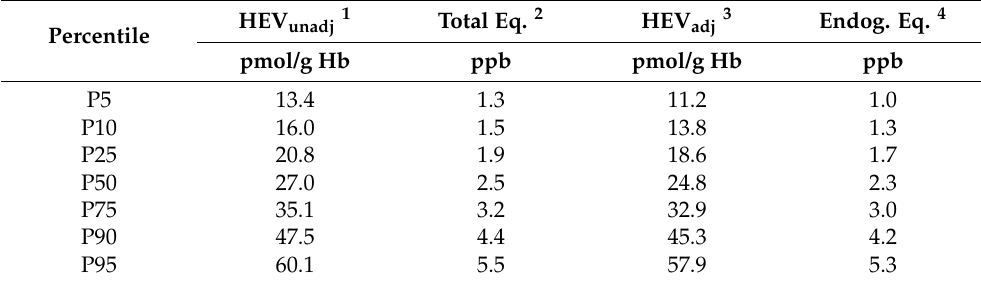
Table 2. Total equivalent and endogenous equivalent EO air concentrations (ppb) using HEV levels (pmol/g Hb) in percentiles of nonsmoker population in the United States, as originally reported by Kirman et al. [3], based on CDC [4] data. HEV unadj 1 Total Eq. 2 HEV adj 3 Endog. Eq. 4 Percentile pmol/g Hb